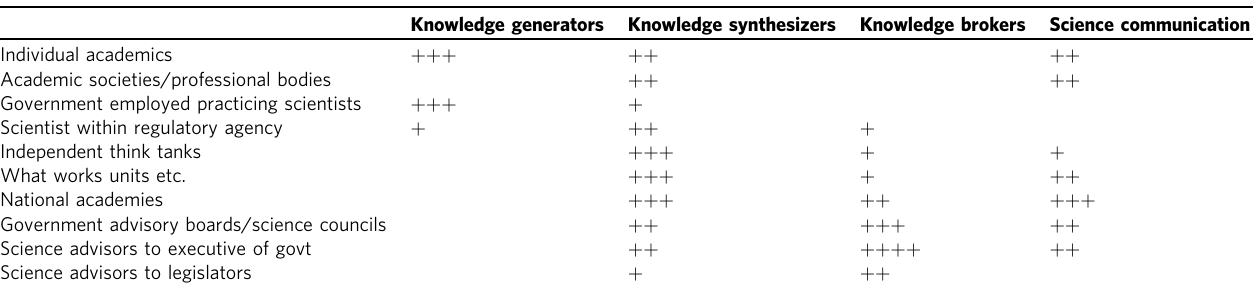
Table 1 Highlights the roles of different actors within science advisory ecosystems. Different roles in a science advisory